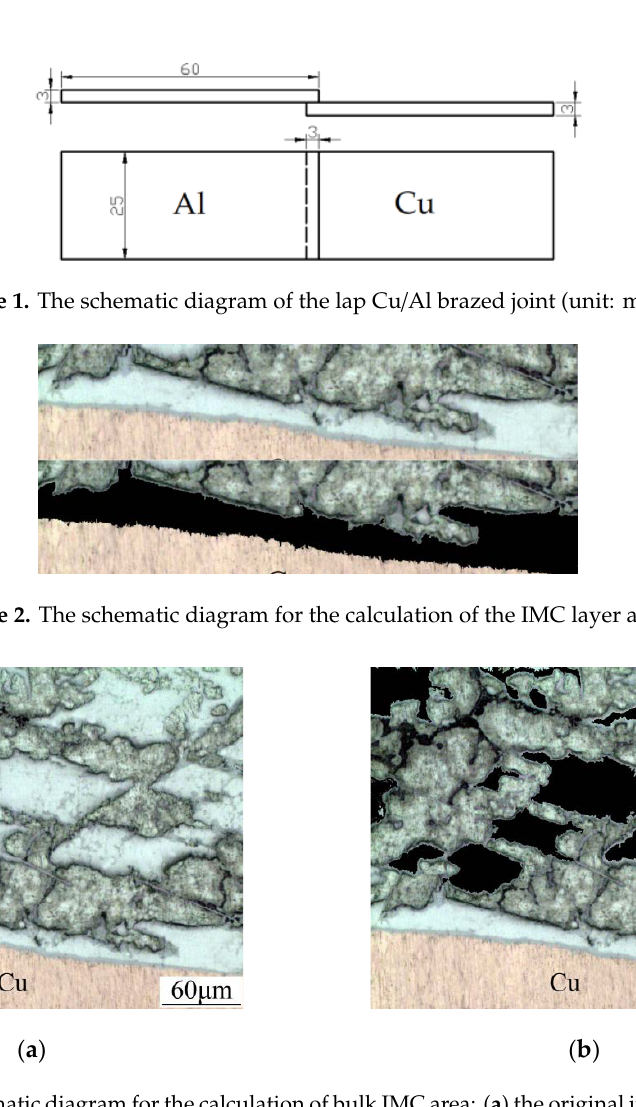
Figure 3. The schematic diagram for the calculation of bulk IMC area: ( a ) the original image; and ( b ) the image processed by Image Pro-Plus software.